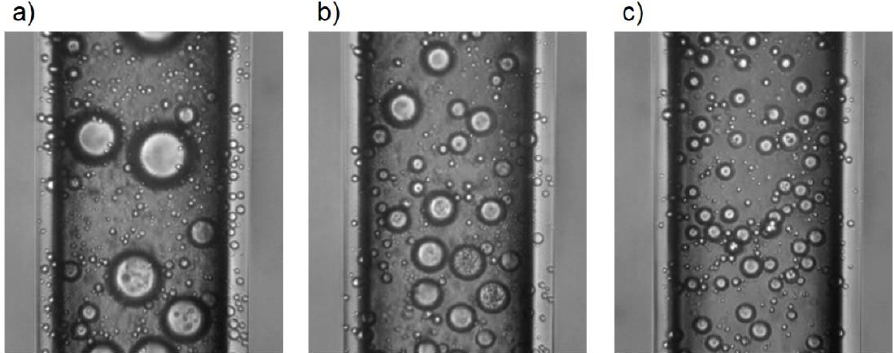
Figure 8. Microscopic images of emulsion systems (type OV 30) flowing in a capillary obtained by the segregation of droplets: ( a ) d av = 15.9 μm ( h = 0.02 m), ( b ) d av = 10.39 μ m ( h = 0.06), ( c ) d av = 7.52 μm ( h > 0.06 m).